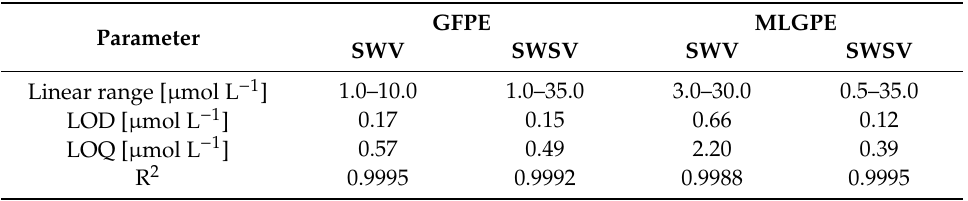
Table1. ComparisonofACdeterminationparameterswithSWVandSWSVonGFPEandMLGPE(n =